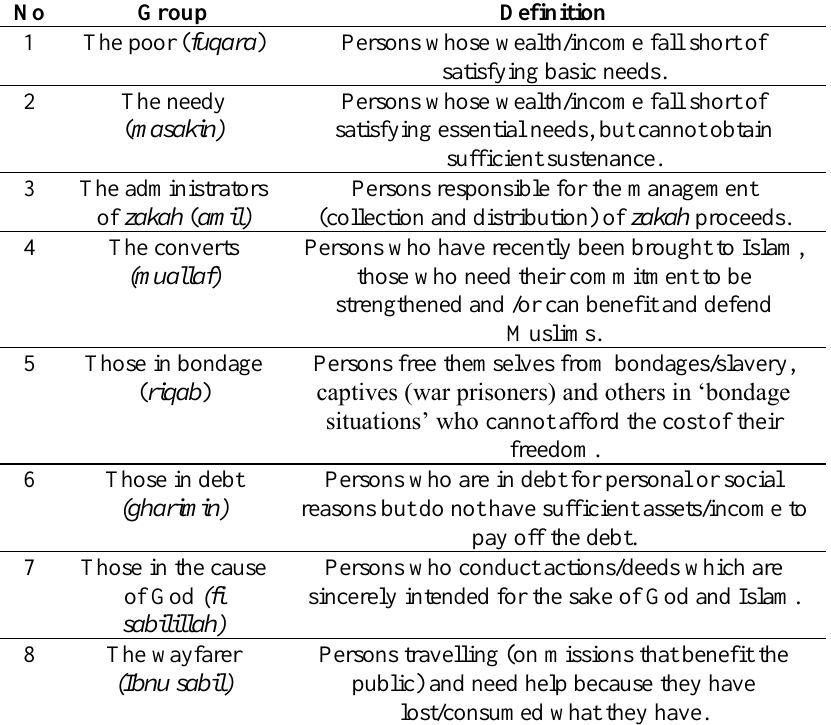
Table 1 Types of Zakah Recipients ( Mustahik